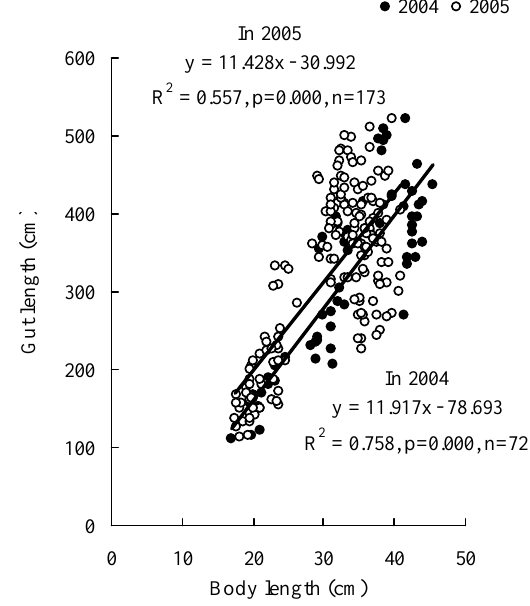
FIGURE 3 . The relationships between the standard body length and gut length in 2004 and 2005. Open symbols and upper line represent individuals in 2005, n = 173, whereas solid symbols and nether line represent individuals in 2004, n =